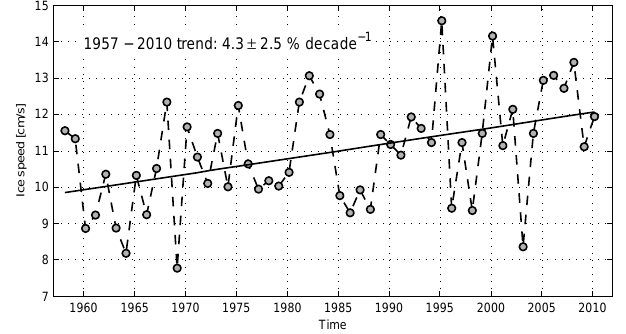
Fig. 7. Annual mean southward Fram Strait sea ice speed based on the NCEP surface pressure difference (Eq. 1). The linear trend for 1957–2010 is included.